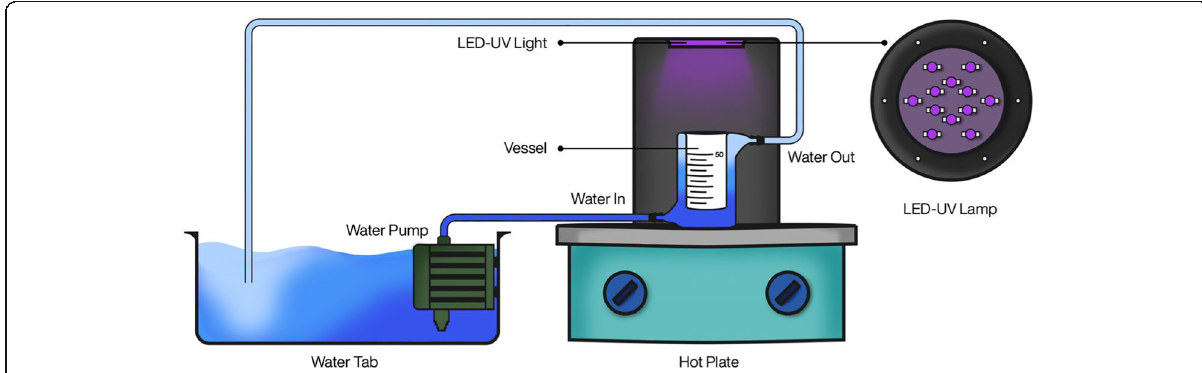
Fig. 1 Design of the photocatalytic